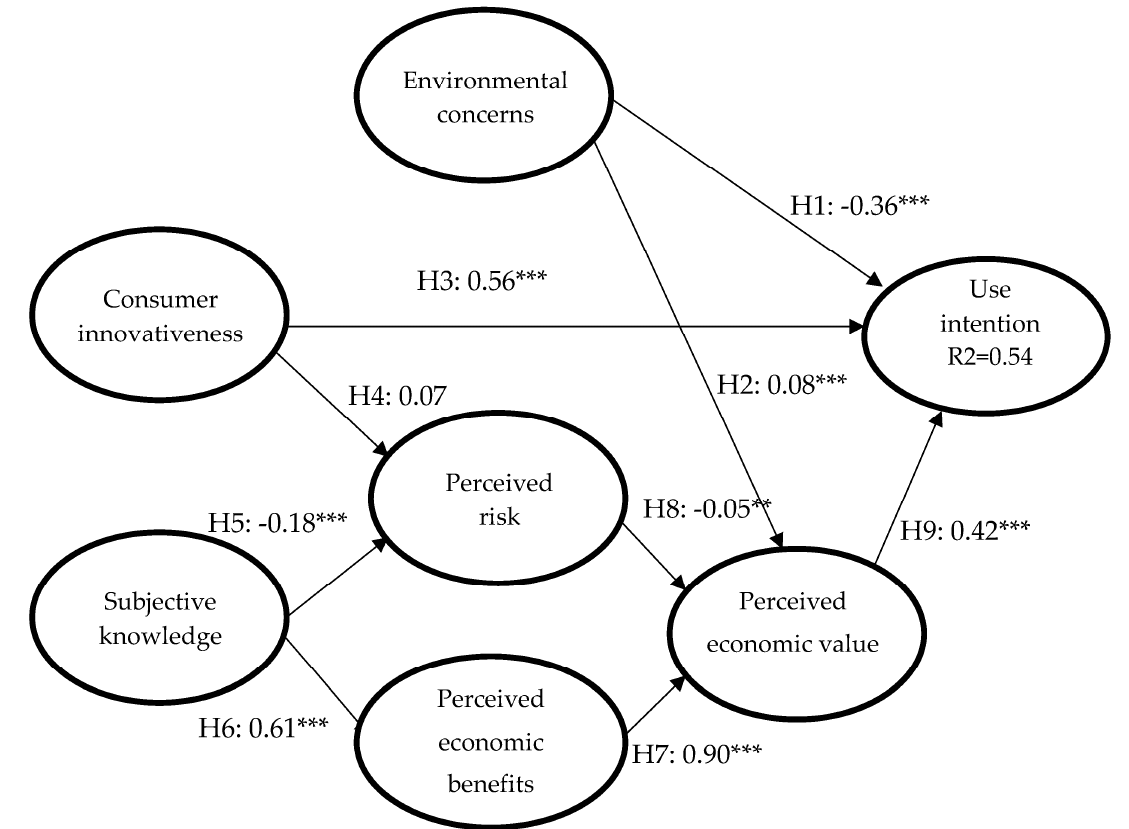
Figure 1. Results of structural model estimation. Note: *** p < 0.01, ** p < 0.05, RMSA = 0.08, CFI = 0.89.